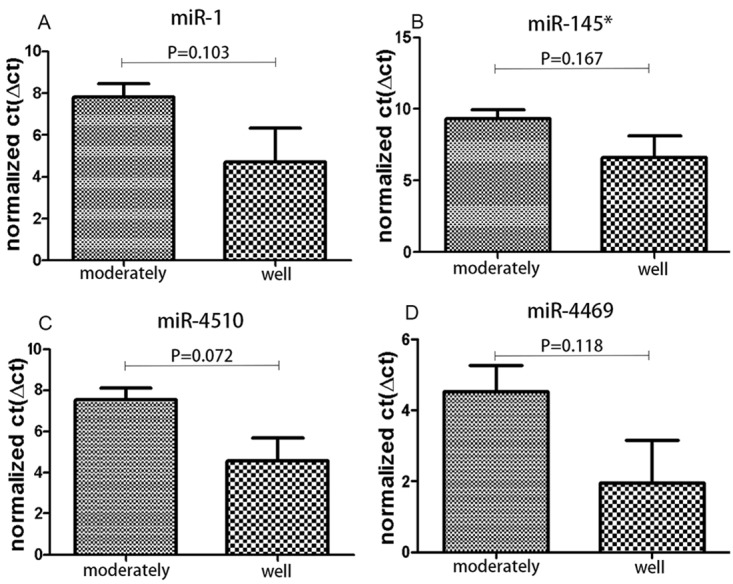
Analysis of the expression levels of miR-1, miR-145*, miR-4510 and miR-4469 between well- and moderately differentiated tumors according to a non-paired t-test.The results show no obvious differences in the expression levels of miR-1, miR-145*, miR-4510 and miR-4469 between well- and moderately differentiated tumors (P>0.05).